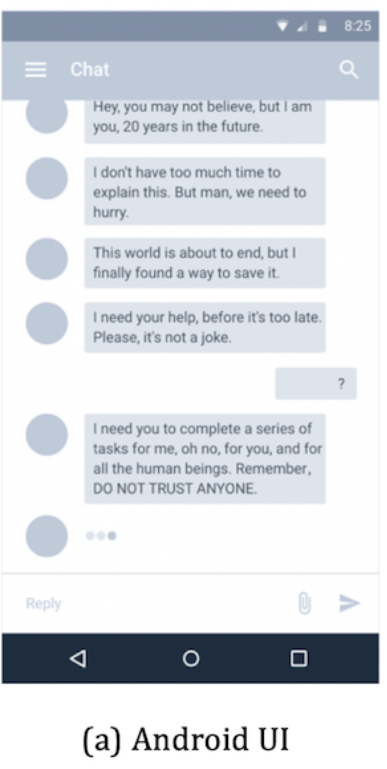
Figure 4. Example app interface and icon. (a) A snippet of one conversation between the system and the user. (b) A display of new mission for the user that he or she can choose to accept or decline. UI: user